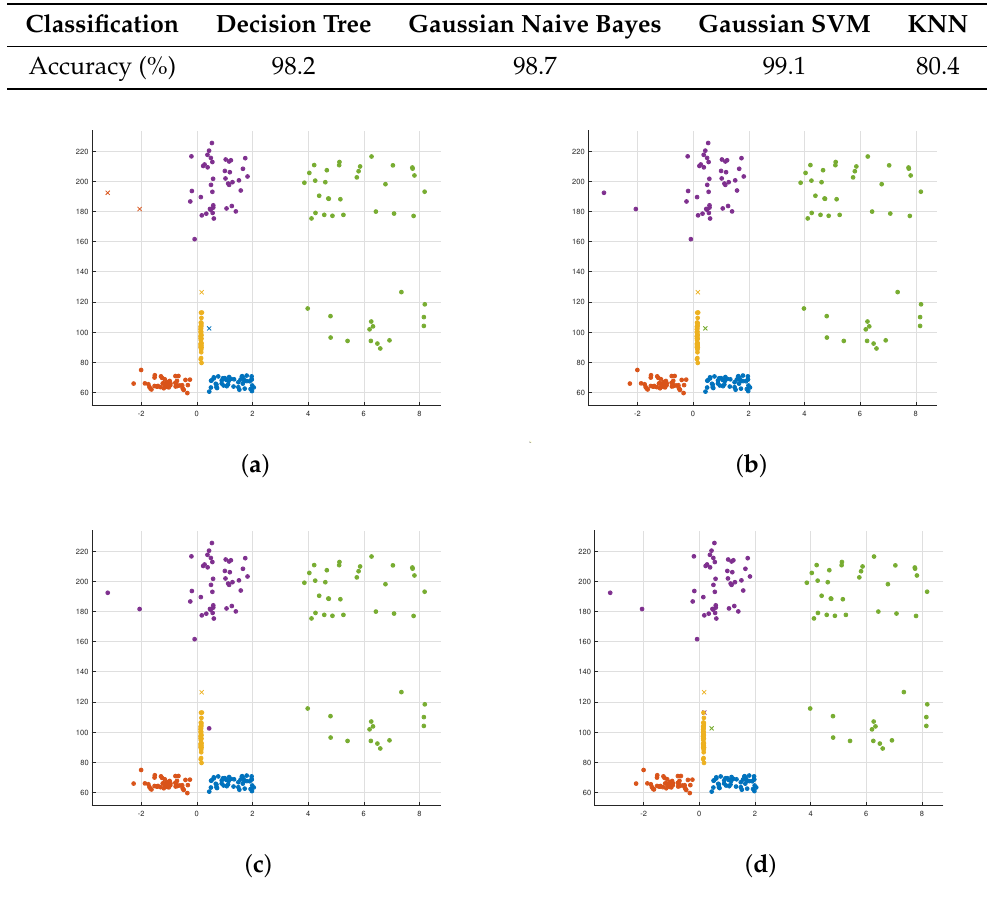
Figure 12. Classification models in Decision Tree, Gaussian Bayes, Gaussian SVM and KNN. ( a ) Deci- sion Tree; ( b ) Gaussian Naive Bayes; ( c ) Gaussian SVM; ( d )